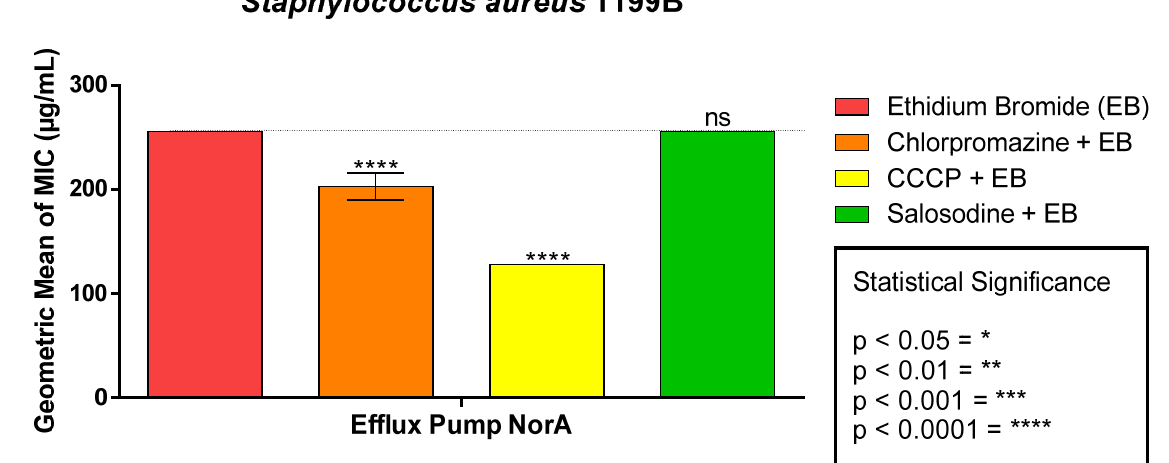
Figure 3. Modifying effect of ethidium bromide by solasodine on S. aureus strain 1199B. The association of solasodine with the antibiotic ciprofloxacin against S. aureus K2068 demonstrated antibiotic potentiation with a reduction in the MIC from 64 µ g/mL to 40 µ g/mL. It also resulted in a reduction in the MIC of ciprofloxacin when tested in conjunction with the efflux pump inhibitors (Figure 4). This suggests that solasodine may be acting on the mechanism of action of the antibiotic, increasing its effect against the bacteria tested.